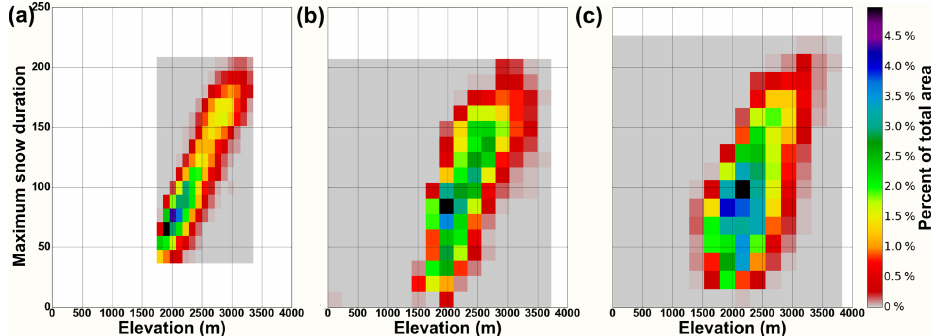
Figure 8. Heat maps showing the relationship between elevation and average maximum consecutive snow duration (maximum snow duration) for three seasonally dominant ecoregions in the Great Basin: (a) the Ruby Mountains, (b) the Sierra Nevada mountains, and (c) the Wasatch– Uinta Mountains.